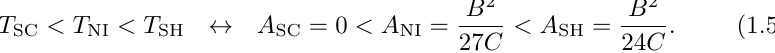
Figure 1. (Left) Contour plot of ˜ f b (˜ s, ˜ p ), a dimensionless form of the bulk free-energy density f b in (1.1b) with Q parameterized as in (1.4), using coordinates ˜ s = The order tensor Q is biaxial except along the lines ˜ p = 0, ˜ p = (Right) Section of the ˜ f b surface cut along the ˜ s axis. Critical points: global minima (solid circles), local maximum (open circle), saddles